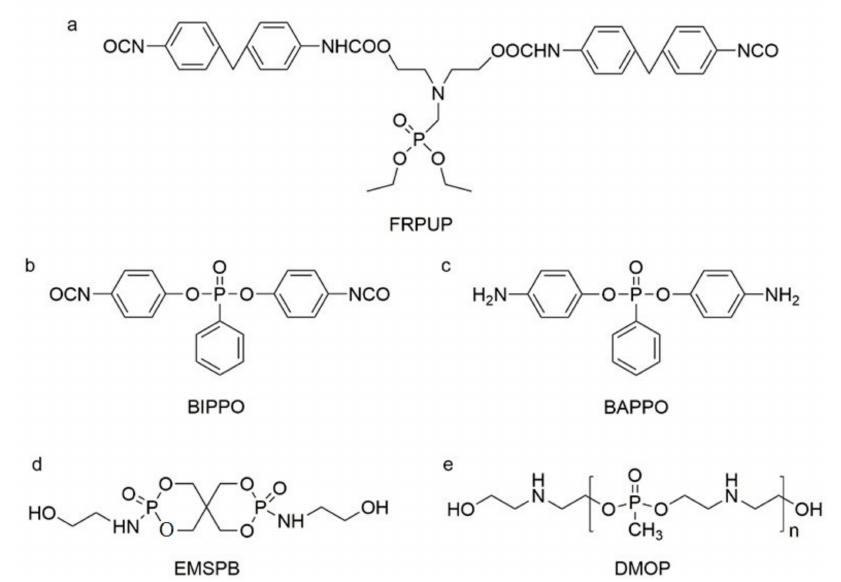
Figure 6. Chemical structures of P–N reactive flame-retardant: ( a ) flame-retardant diisocyanate synthesis by P–N diols reacted with methylene diphenyl diisocyanate; ( b ) P-N flame-retardant bis(4-isocyanatophenyl)phenylphosphine oxide; ( c ) bis(4-aminophenoxy)phenyl phosphine oxide; ( d ) phosphoramidite diols with a double spiro ring structure; ( e ) P–N macromolecular polyester diol using dimethyl methylphosphonate and